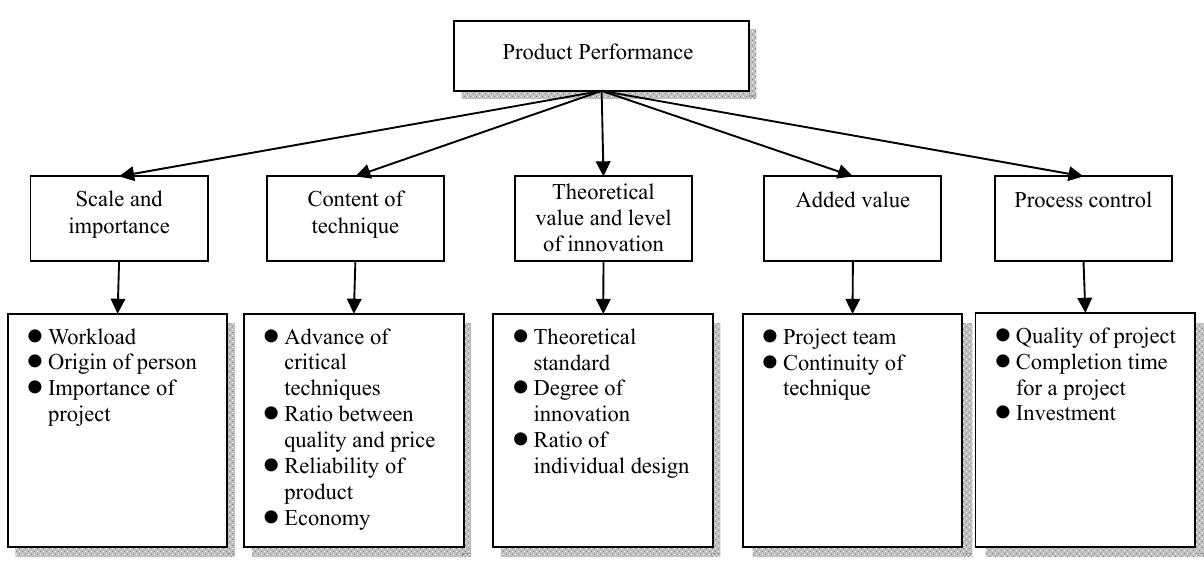
Fig. 11. Attribute framework for the assessment of product performance